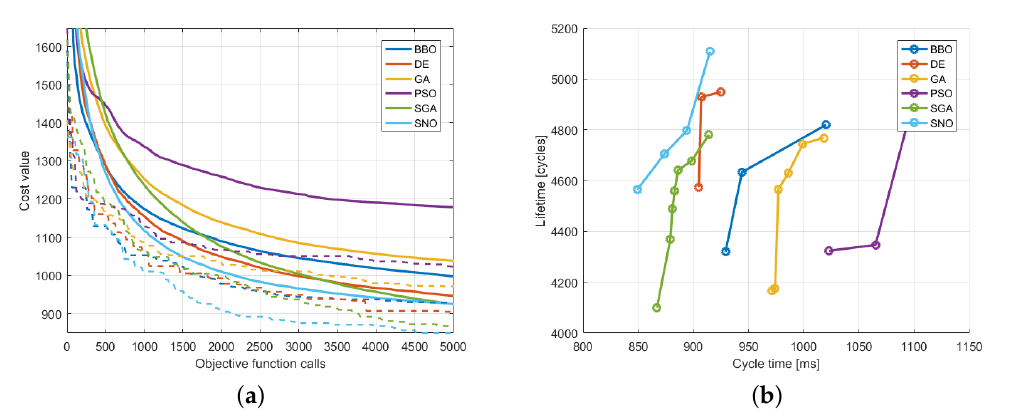
Figure 12. Comparison of the algorithms in terms of convergence curves and Pareto fronts. ( a ) Comparison of convergence curves. ( b ) Comparison of Pareto